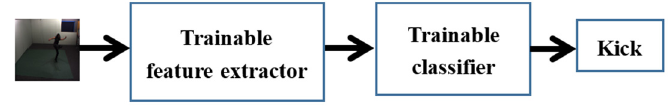
Figure 3. Example of learning ‐ based representation approach.